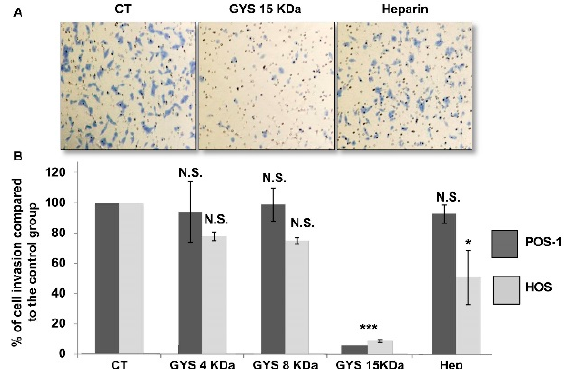
Figure 3. Invasion of the osteosarcoma cell lines, the mouse POS-1 and human HOS, in the presence of OS-EPS derivatives with various molecular weights: 25 µg/mL OS-EPS 15 kDa (GYS15), 50 µg/mL